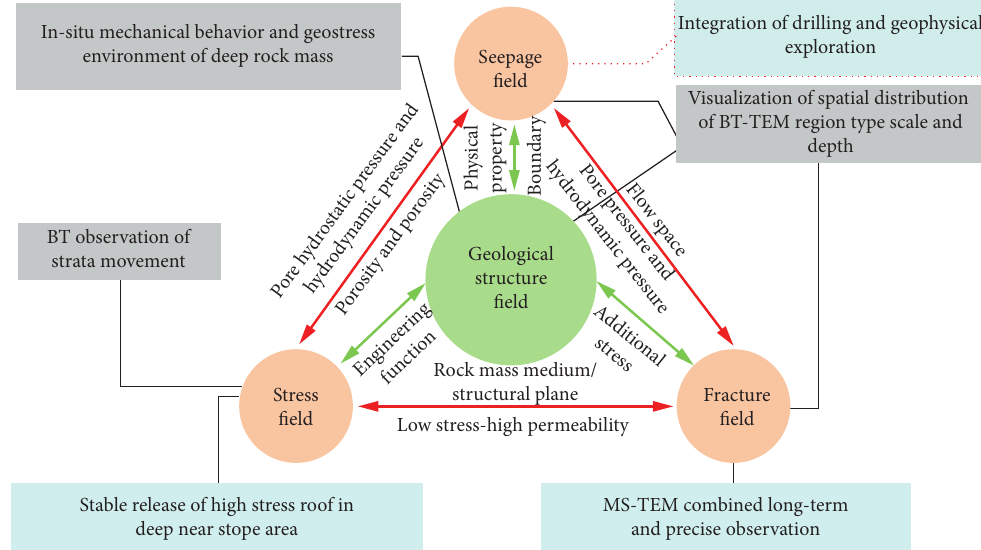
Figure 3: Multifield coupling relationship of coal and rock mass in steeply inclined coal seam.